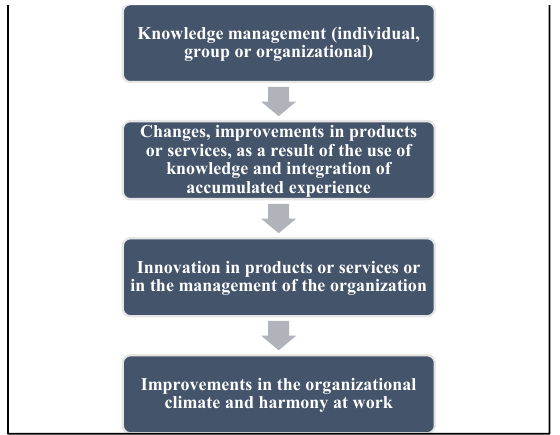
Figure 3. Innovation as a product of knowledge management. Source: self-made.